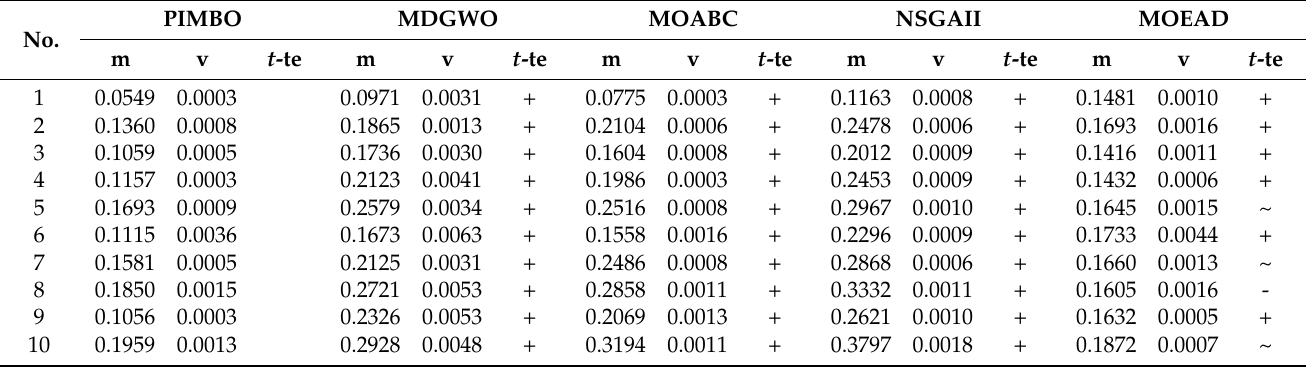
Table 5. Comparison of the experimental results of the five algorithms through the IGD metric.